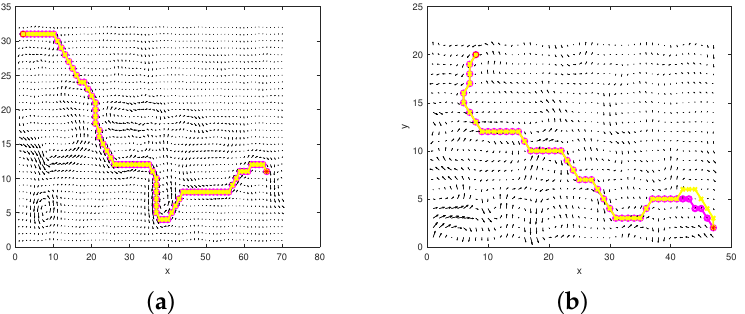
Figure 8. The paths established by two algorithms in the first type of grid maps. ( a ) The paths from (2,31) to (66,11) established by the improved A* algorithm and neural network model in 32 × 70 map. ( b ) The paths from (8,20) to (47,2) established by the improved A* algorithm and neural network model in 21 × 47 map.